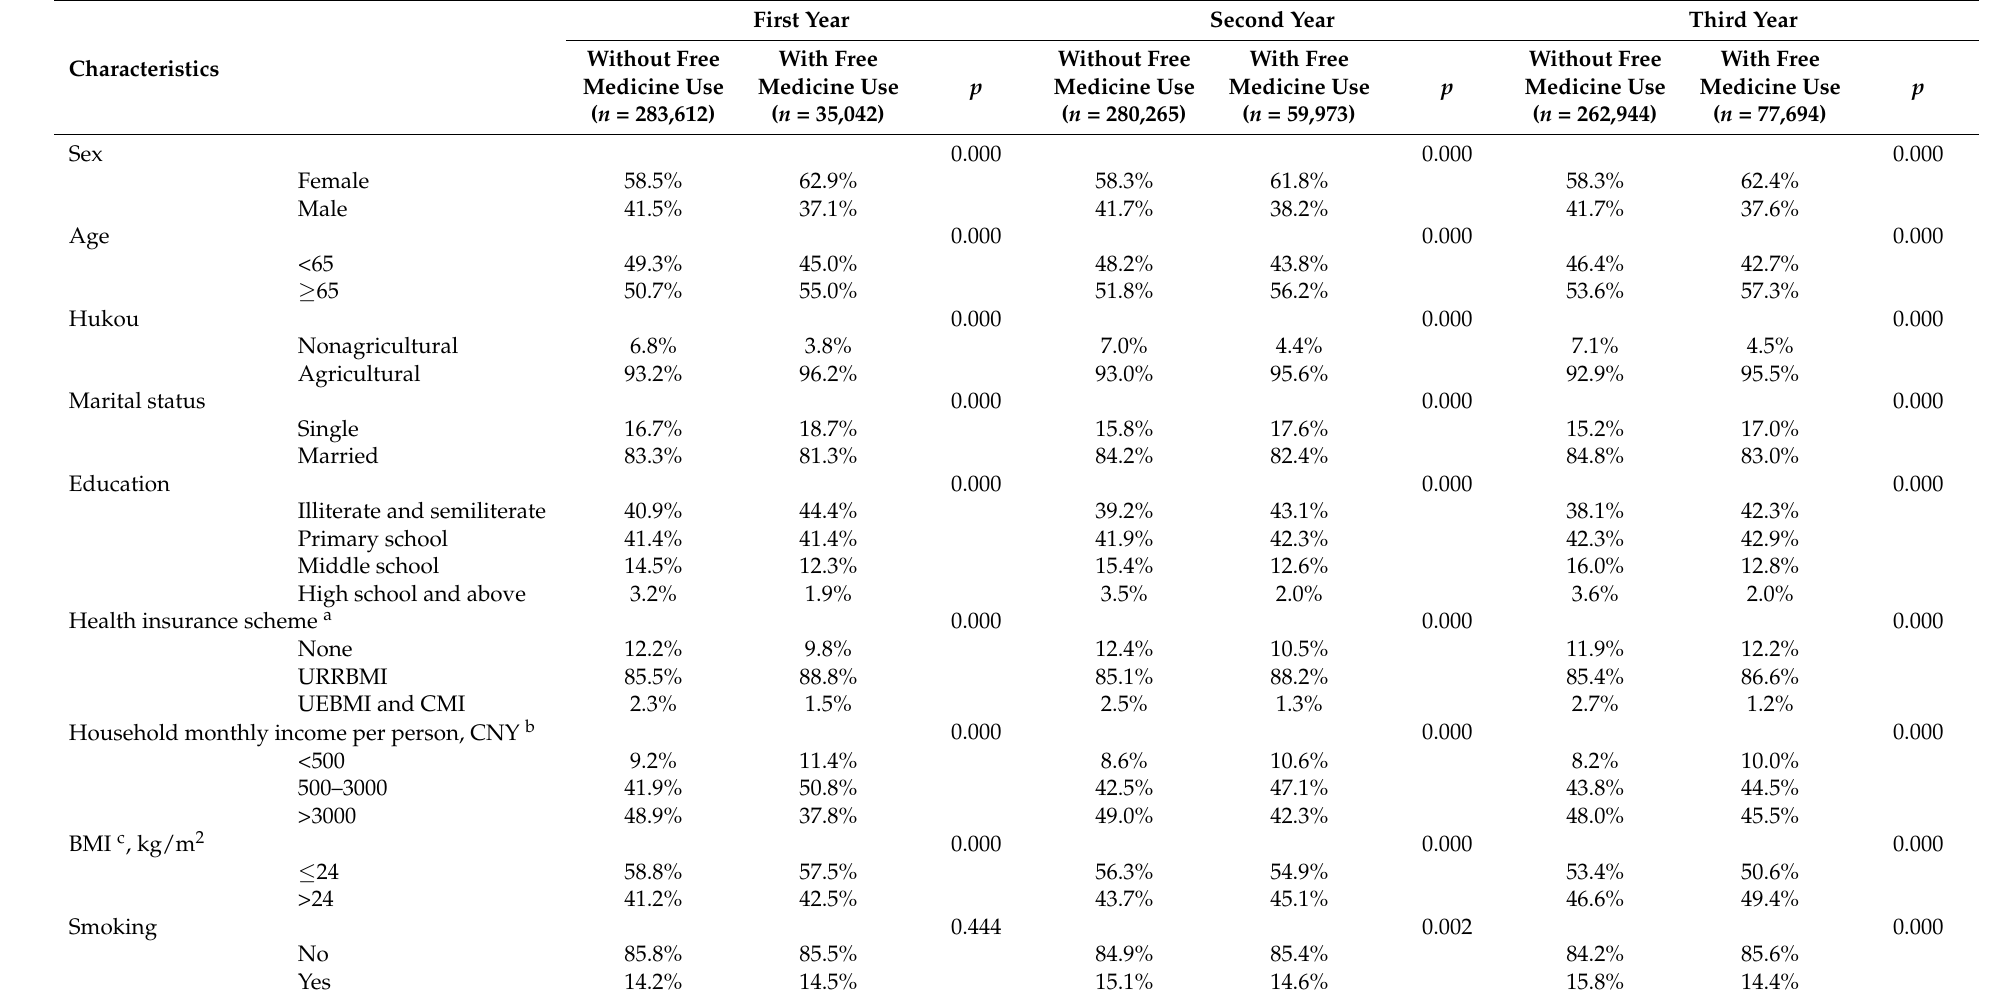
Table 2. Characteristics of sample patients with and without free medicine